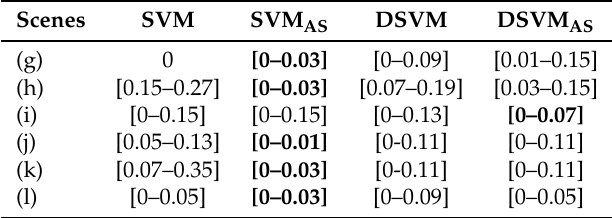
Table 7. Mean square error range on the 800 × 800 resolution scenes. The bold values simply indicate the minimum Mean square error range.